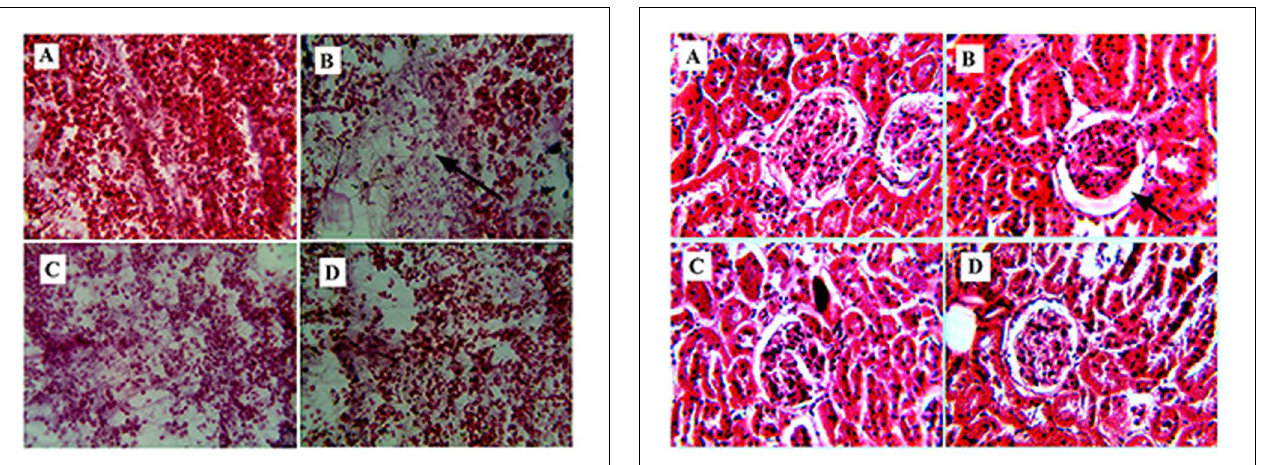
metal chelating agent and conjugate with Zn 2 + or Mg 2 + and perform its activity (Pathak et al., 2011).